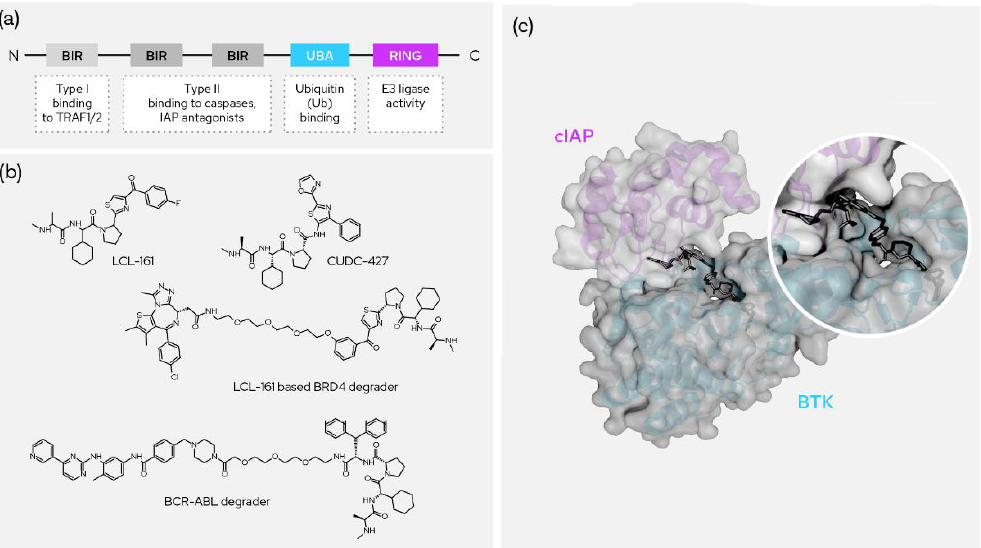
Figure 6. SNIPERs and XIAP-based degraders. ( a ) The domain structure of cIAP; ( b ) the two most prominent recruiters and two published degrader molecules using them; ( c ) ternary crystal structure between molecular degrader, cIAP and BTK (PDB: 6W70).